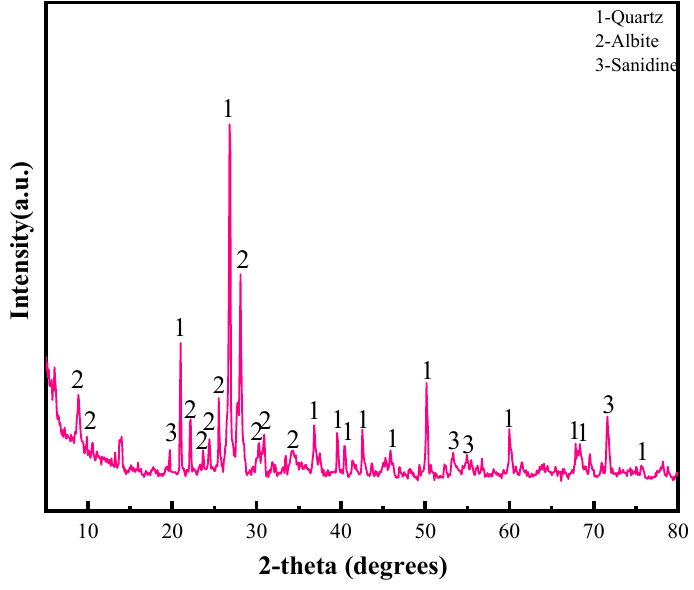
Figure 2. XRD of tailing sand.